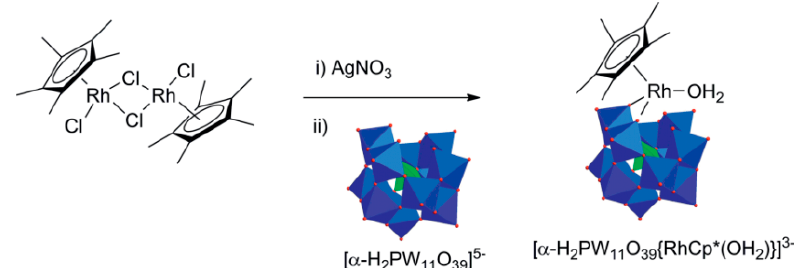
Figure 12. Synthesis of the organometallic derivative [ α -H 2 PW 11 O 39 (Rh III Cp*(OH 2 ))] 3 − . Color code: WO 6 octahedron, navy blue; PO 4 tetrahedron, green; O, red ball. Reprinted with permission from [54]. Copyright © 2019 Wiley-VCH Verlag GmbH and Co. KGaA.